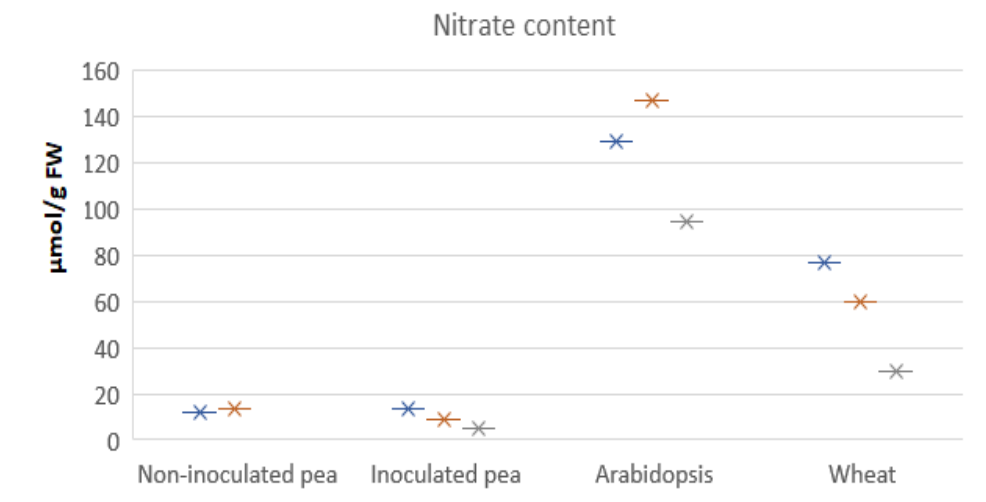
Figure 2. NO 3 − concentrations in shoots of pea [25–27], A. thaliana [11,16,28] and wheat [29–31]. The tissue NO 3 − concentrations, plotted using star symbols, were collected and pooled from these publications (Supplemental Table S1). FW: fresh weight. Blue, orange and grey stars indicate data from different publications.